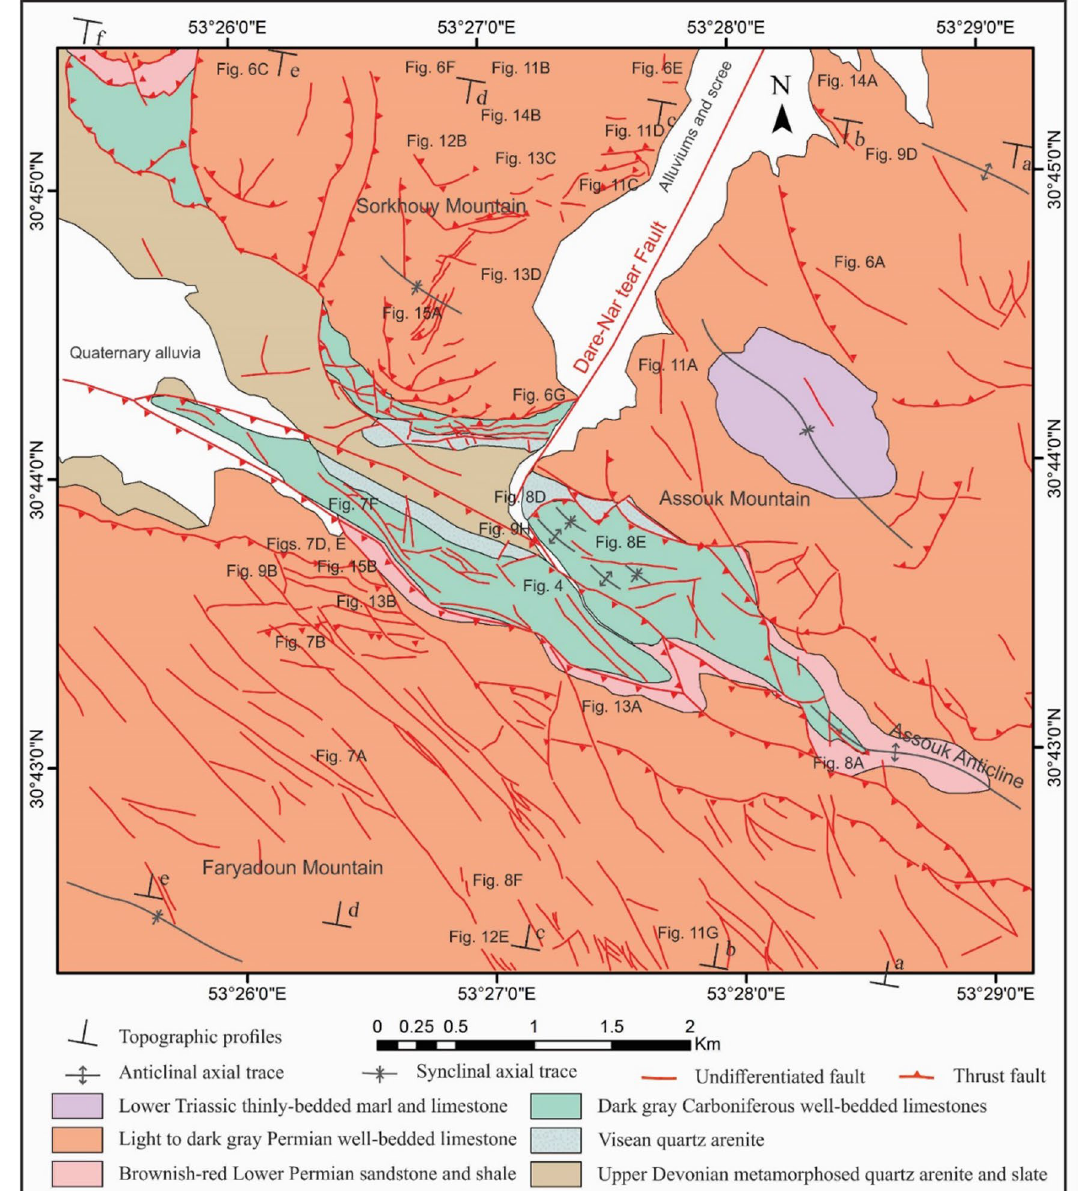
Figure 3. The geological map of the Faryadoun and Dare-Nar area prepared after field working by authors using CorelDraw 2018 and ArcGIS